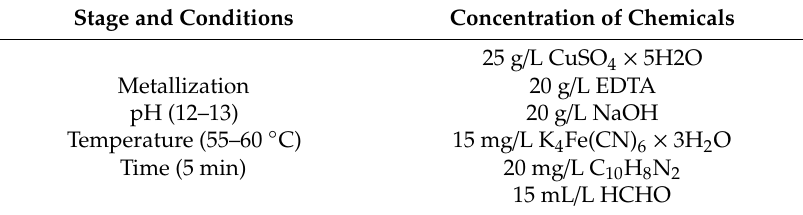
Table 4. The Solution Composition and Experimental Conditions of Electroless Copper Plating.